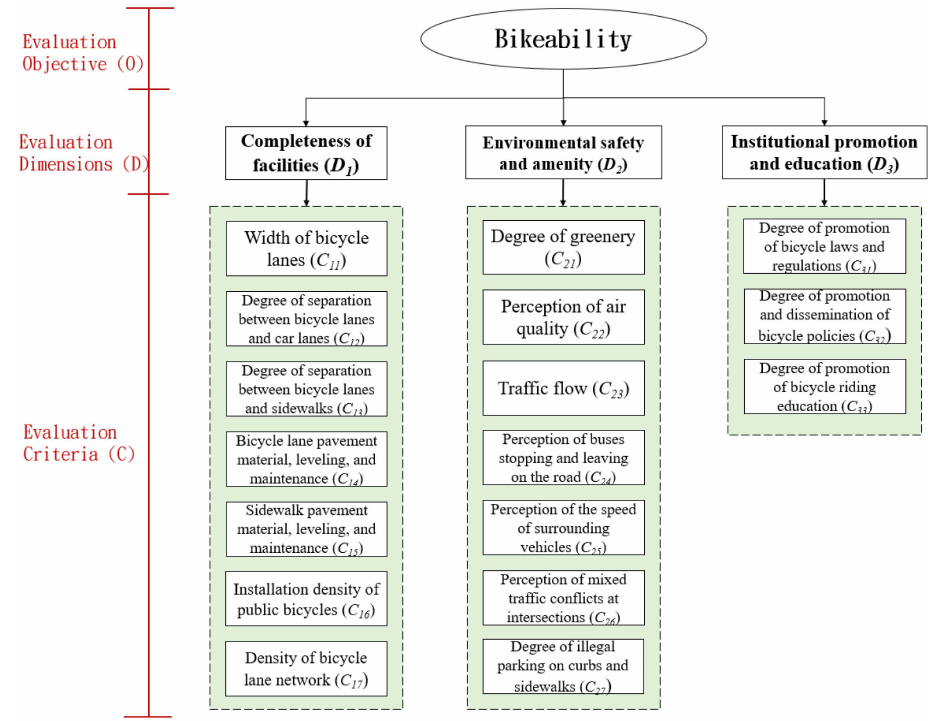
Figure 1. Bikeability evaluation framework.